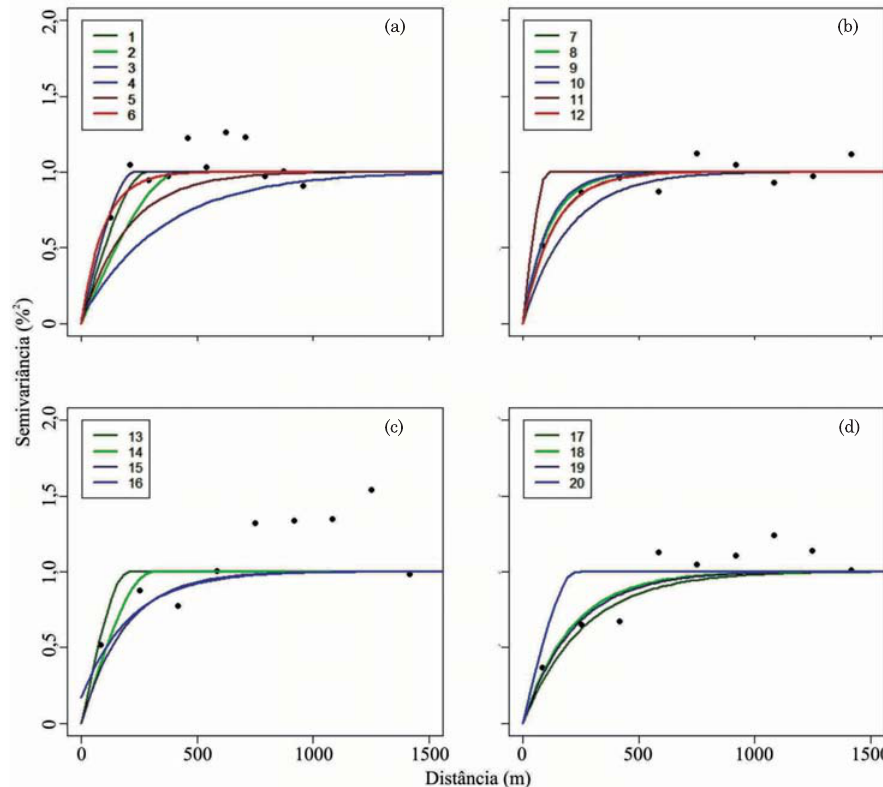
Figura 3. Semivariogramas escalonados para inverno (a), primavera (b), verão (c) e outono (d).